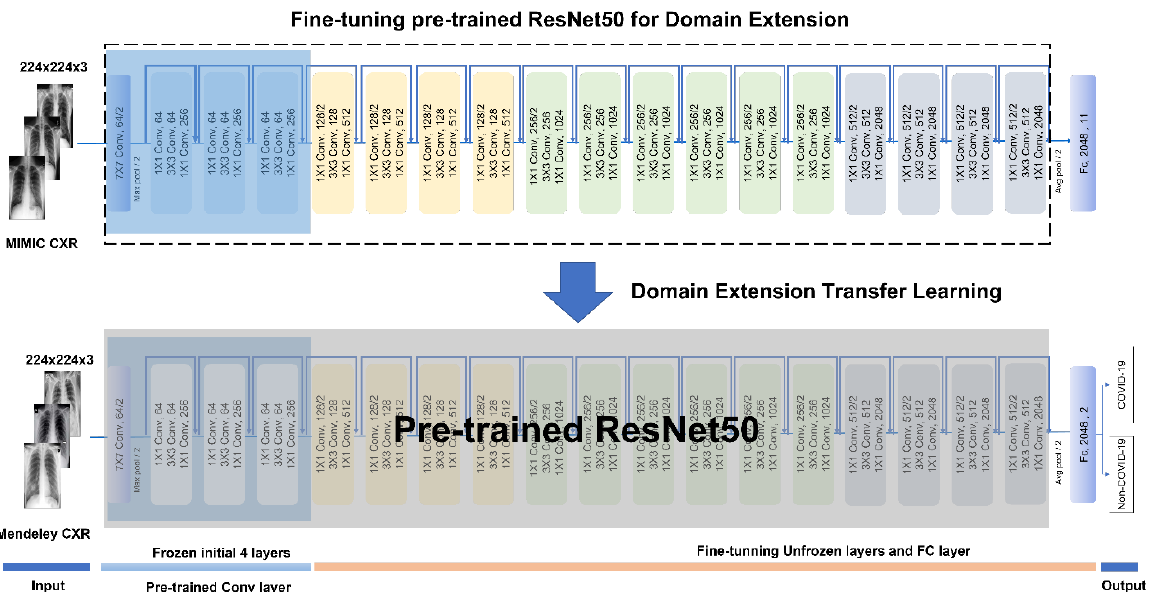
Figure 4. Fine-tuning strategy for domain extension transfer learning .